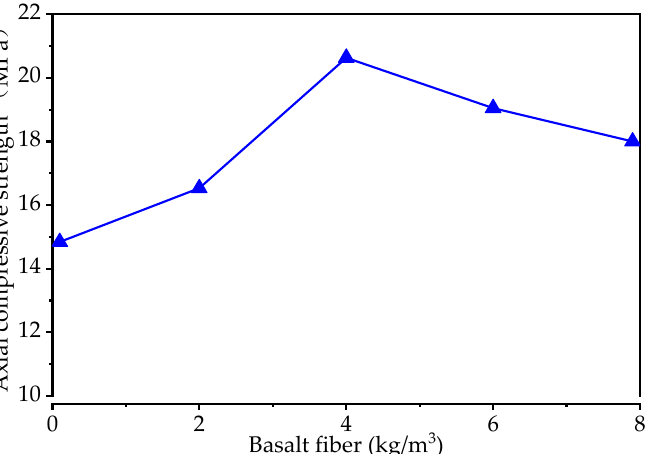
Figure 5. The axial compressive strength of specimens with different levels of basalt fiber content.